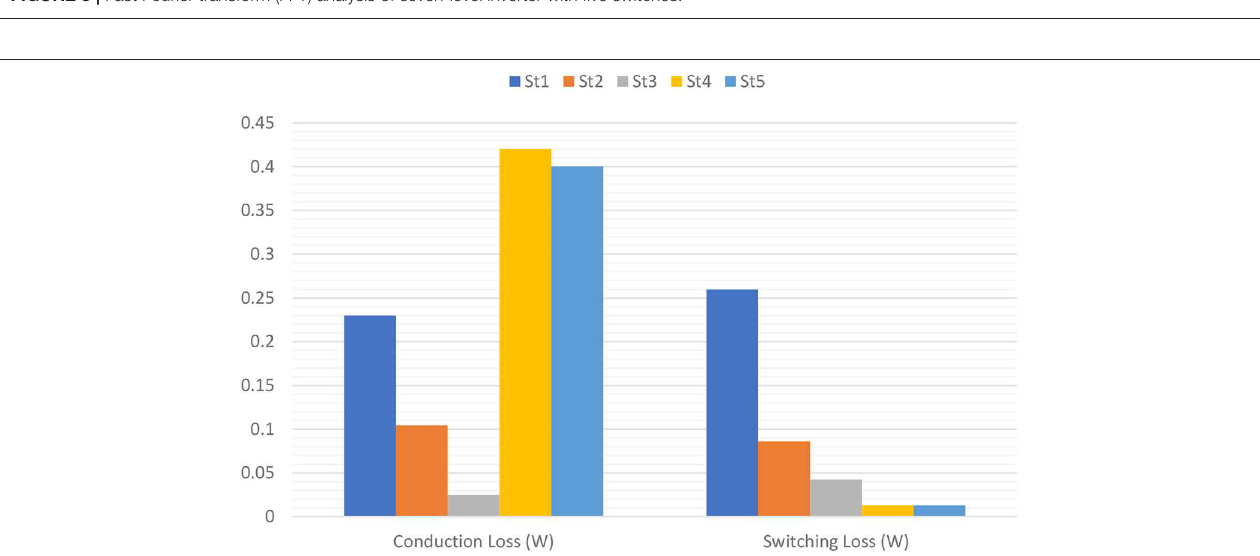
FIGURE 8 | Fast Fourier transform (FFT) analysis of seven-level inverter with five switches.